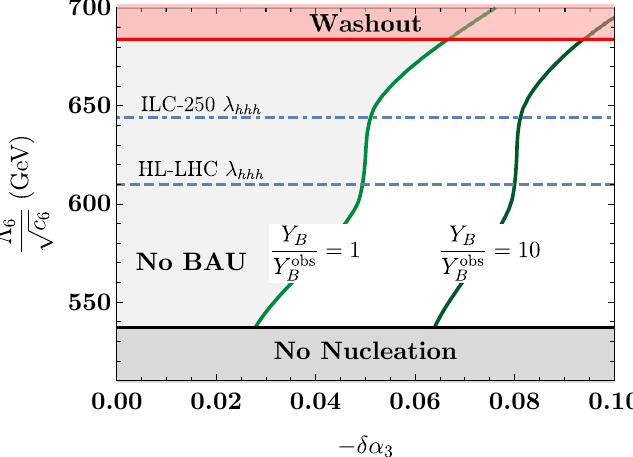
p Figure 4 . Viable parameter space as a function of (cid:14)(cid:11) 3 and (cid:3) 6 = c 6 for (cid:14)(cid:11) 2 = 0. The grey region at p lower values of (cid:3) 6 = c 6 is ruled out due to bubbles of true vacuum not being able to nucleate. The transparent grey region on the left shows where an insu(cid:14)cient BAU is produced. The red region is where an initially su(cid:14)cient BAU is produced, but the phase transition is too weakly (cid:12)rst order, so that the EW sphalerons wash out the BAU in the broken phase, assuming a washout factor of F W = 10%, de(cid:12)ned in eq. (4.6). The light and dark green contours correspond to obtaining the correct BAU, and a factor of ten more than required, respectively. Also shown are contours corresponding to the 68% CL bounds from HL-LHC (dashed) and ILC-250 (dot-dashed), as found in